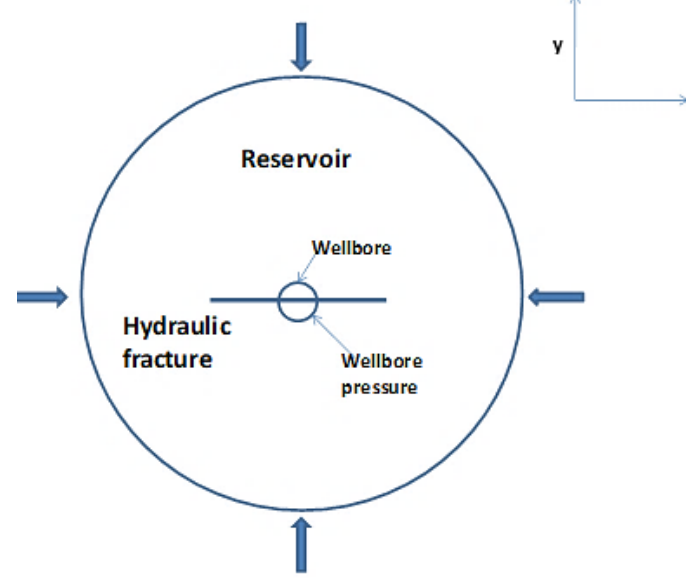
Figure 1. Schematic of the fracture reservoir used for production model.